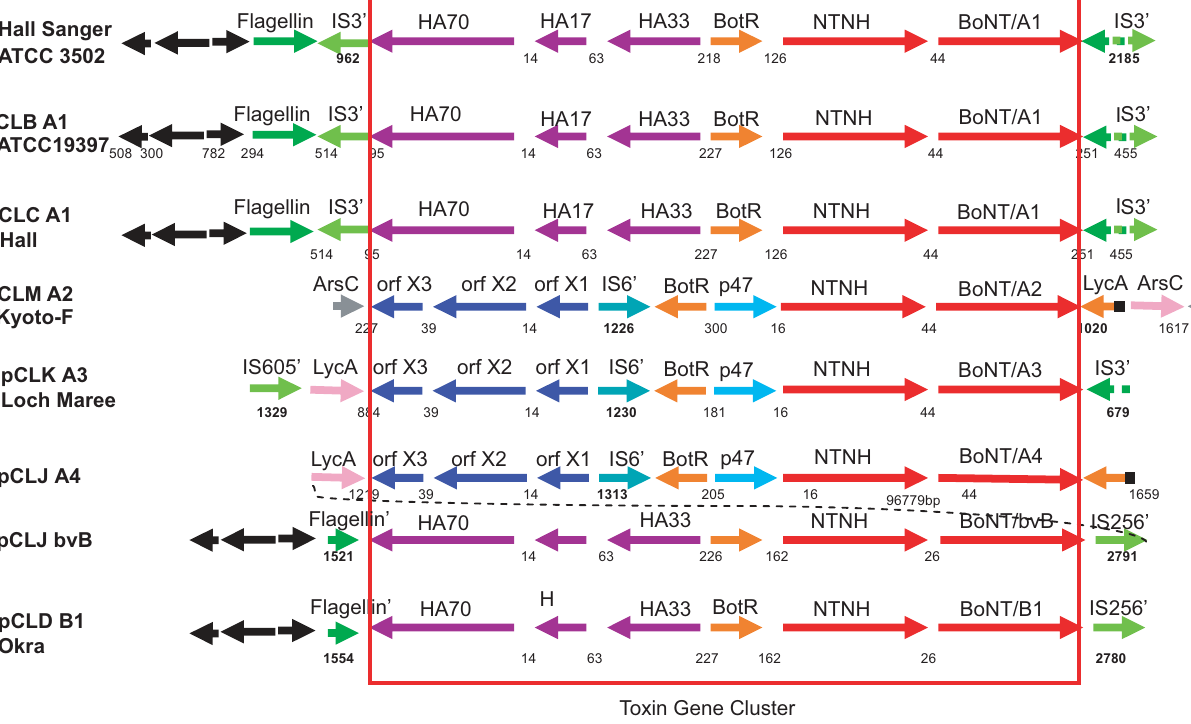
Figure 1. Diagram illustrating the neurotoxin complex gene arrangements found within strains representing the four different BoNT/A1-A4 and the BoNT/B1 subtypes of C.botulinum. The gene arrangements within the three BoNT/A1 strains are identical to each other and to the BoNT/B1 okra strain which includes the HA70, HA17, HA33, BotR, NTNH and BoNT genes. This arrangement is different from the three strains that represent the BoNT/A2, BoNT/A3 and BoNT/A4 subtypes which contains the orfX3, orfX2, orfX1, BotR, p47, NTNH and BoNT genes. The BoNT/A4 complex is connected by dashed lines to the BoNT/bvB complex to indicate its presence within the same plasmid yet separated by about 97 kb. Partial IS elements (designated IS’) are indicated in green and identified by IS family designations. Genes flanking the toxin complex include the lyc A, ars C or flagellin genes. The presence of a partial flagellin gene is designated as flagellin’. Hypothetical proteins are indicated in black. Numbers indicate the distances in nucleotides within intergenic